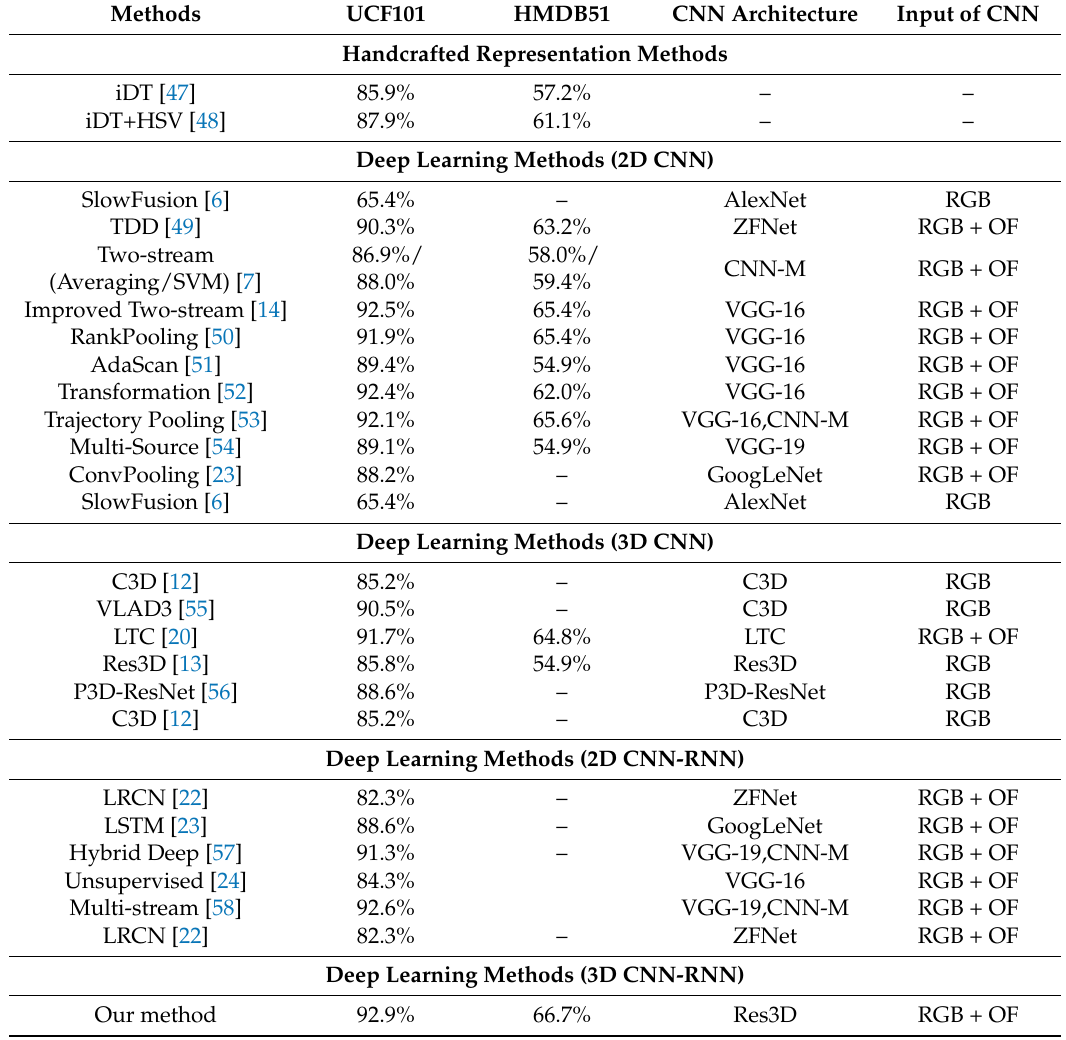
Table 8. Comparison of our method with state-of-the-art